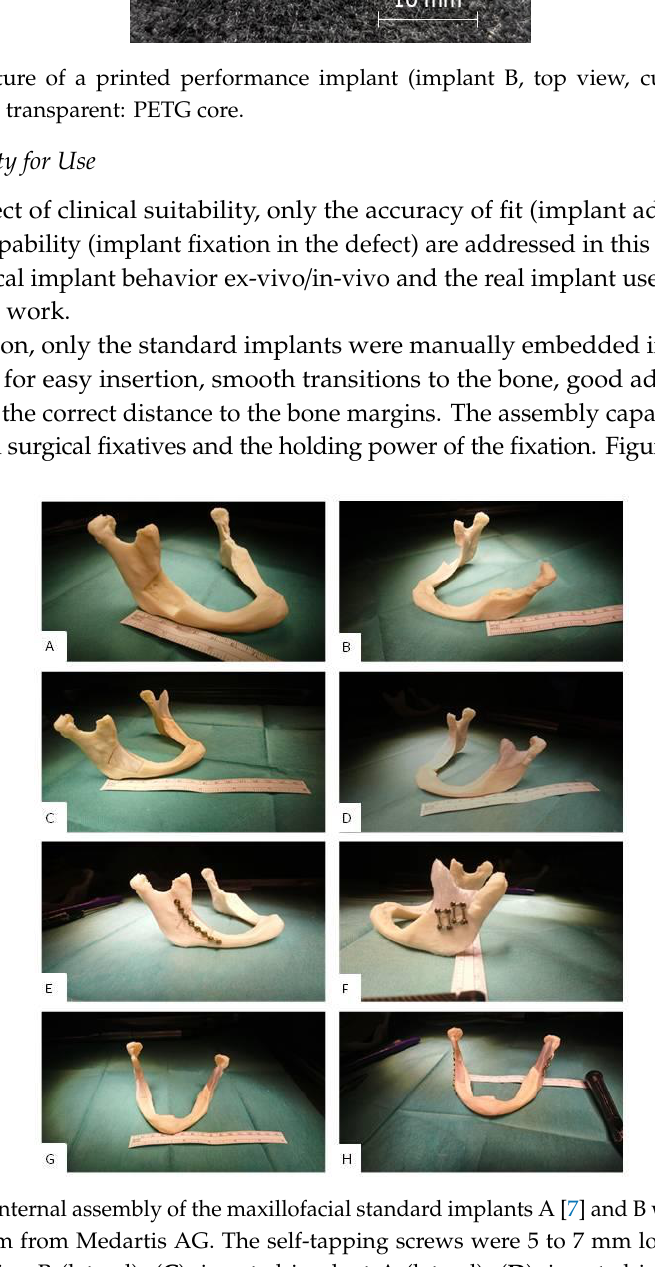
Figure 5. Structure of a printed performance implant (implant B, top view, cut at Z = 8 mm); white: TPU shell, transparent: PETG core.